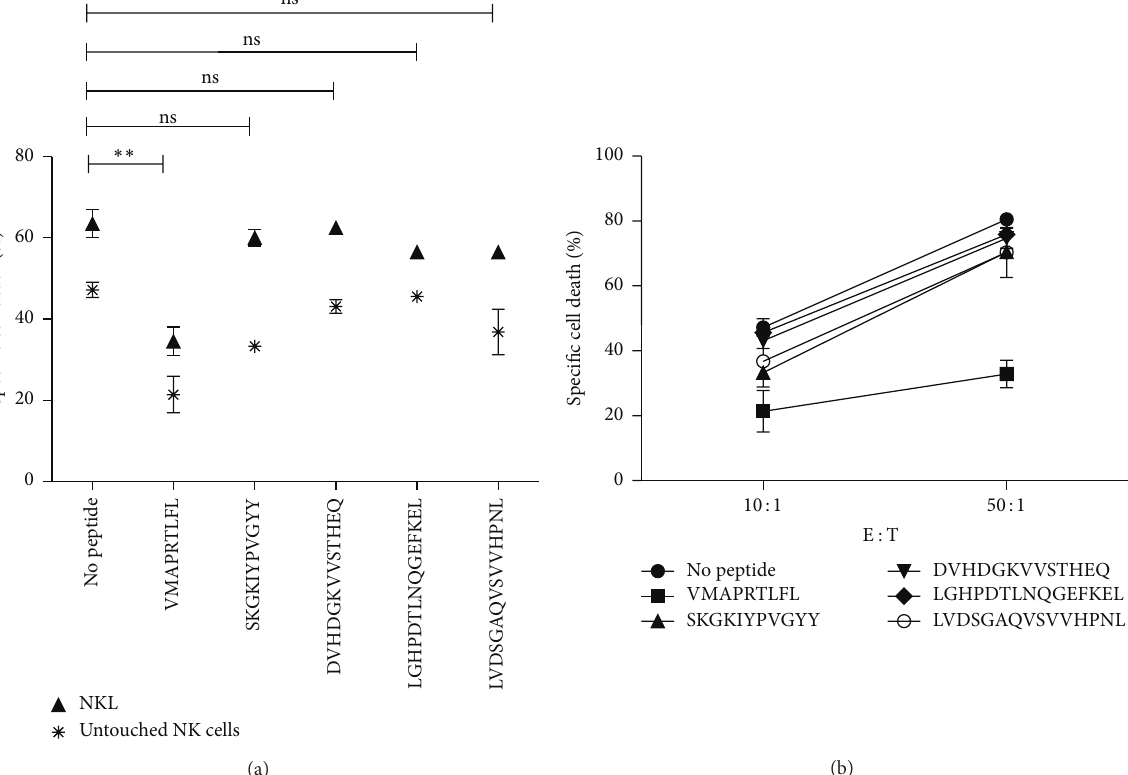
Figure 2: Noncanonical peptides impact on protection against NK cell cytotoxicity. (a) T2E cells were incubated in the presence or absence of peptides prior a 4-hour cytotoxicity assay with NK cells (NKL) or fresh isolated untouched CD56 + NK cells from PBMCs at a E: T ratio of 10: 1 and (b) untouched NK cells at 10 :1 or 50 : 1. Specific cell death was calculated based on the percentages of dead (7-AAD + ) and live cells (CFSE + ) ± SEM. Specific cell death of target cells incubated with peptide was compared to target cells without peptide incubation.